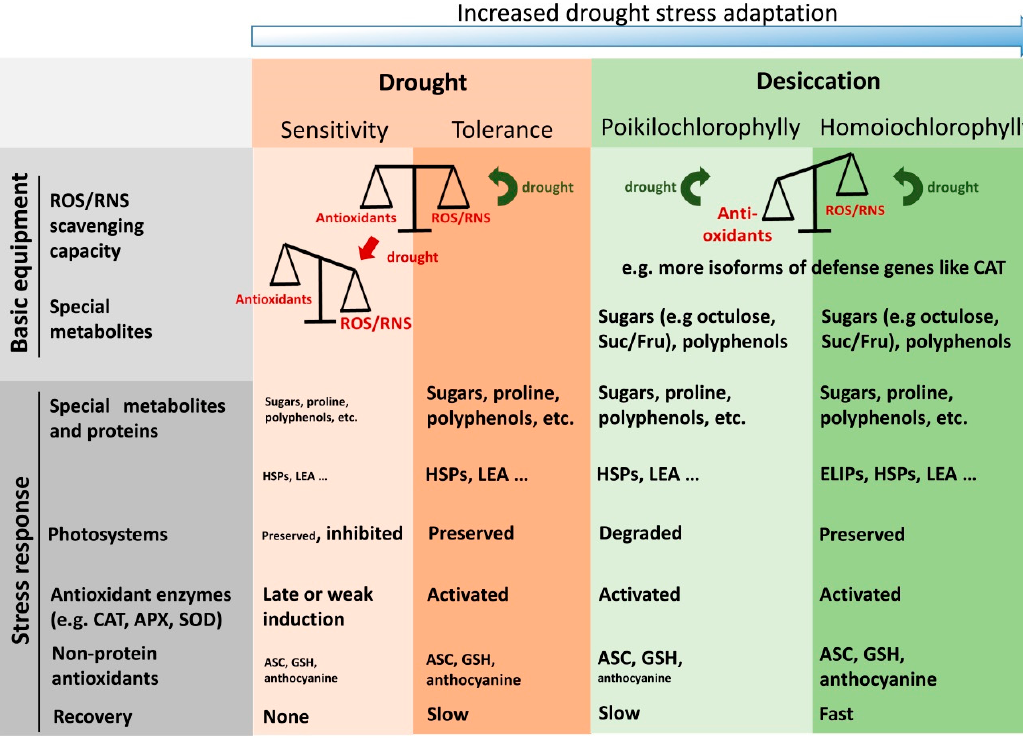
Figure 2. Characteristic features of drought-sensitive, drought-tolerant and desiccation-tolerant plants. The figure summarizes properties related to metabolism, antioxidant defense, and recovery which often are associated with the physiological traits. Red arrow: reactive oxygen species (ROS) / reactive nitrogen species (RNS) gain prevalence; green arrow: status is preserved following drought. Fond size correlates with the strength of stress responses measured. ROS, reactive oxygen species; RNS, reactive nitrogen species; HSP, heat shock protein; LEA, late embryogenesis abundant protein; ELIP, early light-inducible protein; Suc / Fru, sucrose to fructose ratio; CAT, catalase; APX, ascorbate peroxidase; SOD, superoxide dismutase; ASC, ascorbate; GSH, glutathione.